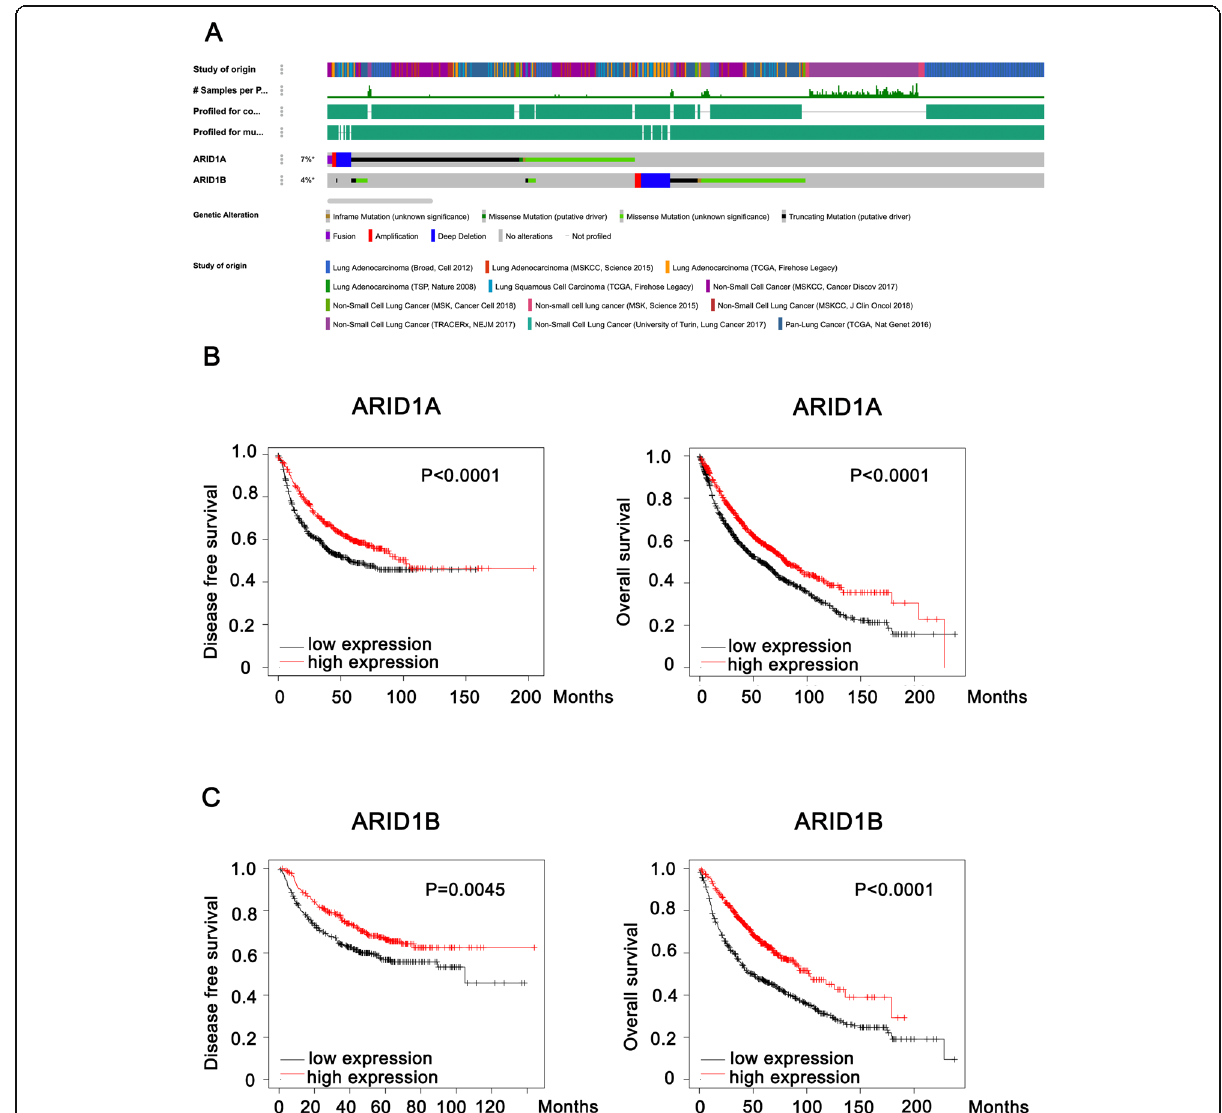
Fig. 1 ARID1 subunits are tightly associated with the prognosis of NSCLC. a . The prevalence of ARID1 subunits mutations in NSCLC patients according to the cBioPortal for Cancer Genomics; b . The relationship between ARID1A expression and the prognosis of NSCLC patients; c . The relationship between ARID1B expression and the prognosis of NSCLC